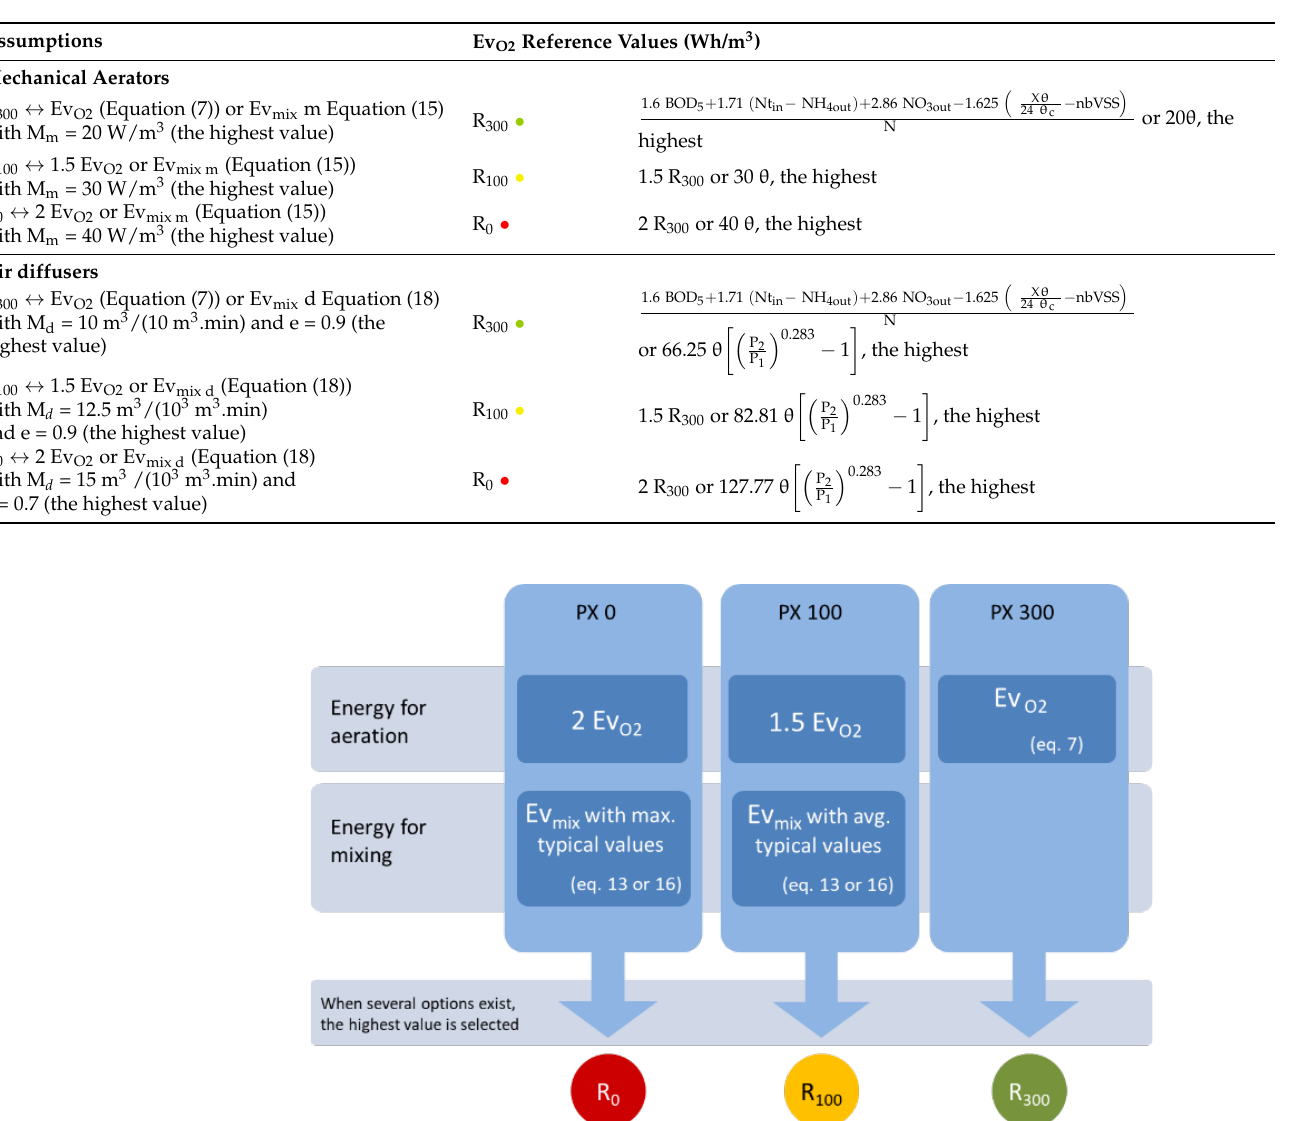
Table 1. The reference values of energy consumption for aeration in AS systems.